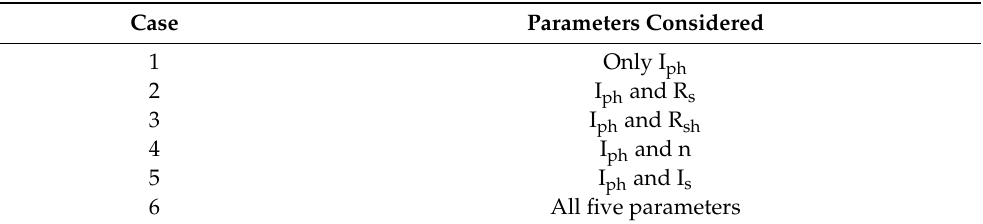
Table 3. Cases for considering the parameter variation with shading in the modelling of the 10 W PV module.